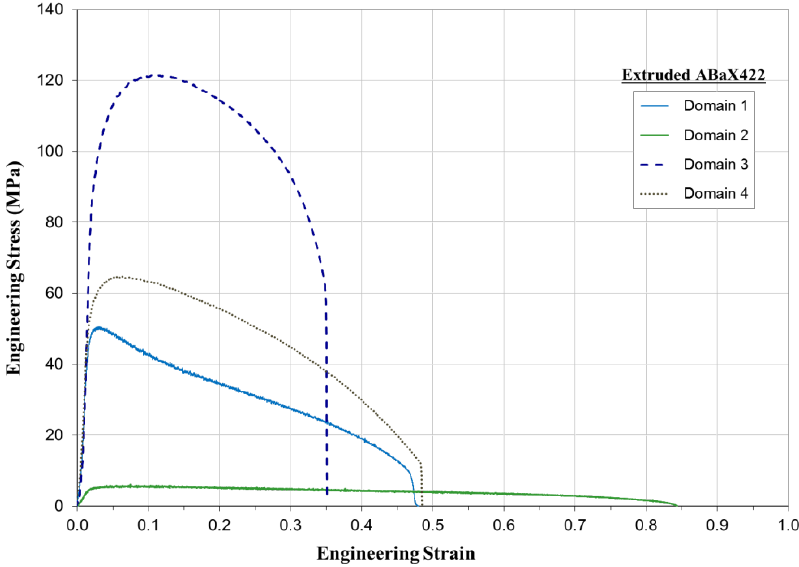
Figure 7. Tensile flow curves for the specimens deformed in the four domains of the processing maps: Domain 1 (380 °C/0.0003 s −1 ), Domain 2 (500 °C/0.0003 s −1 ), Domain 3 (380 °C/2.3 s −1 ), and Domain 4 (500 °C/2.3 s −1 ). Table 1. The tensile mechanical properties of the specimens that correspond to the four domains in the processing maps of the extruded ABaX422 alloy.